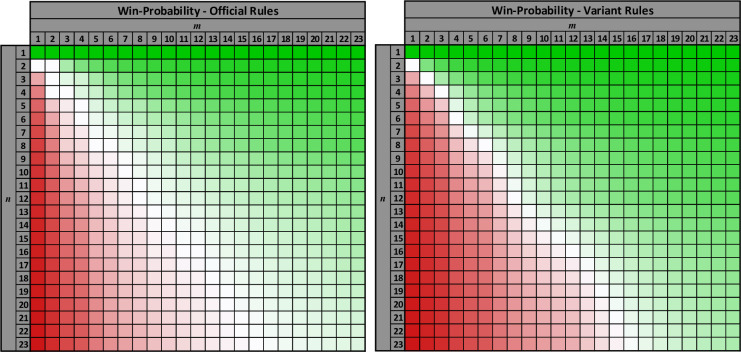
Win probabilities for both rules variants (all plots are based on optimal play by both players).